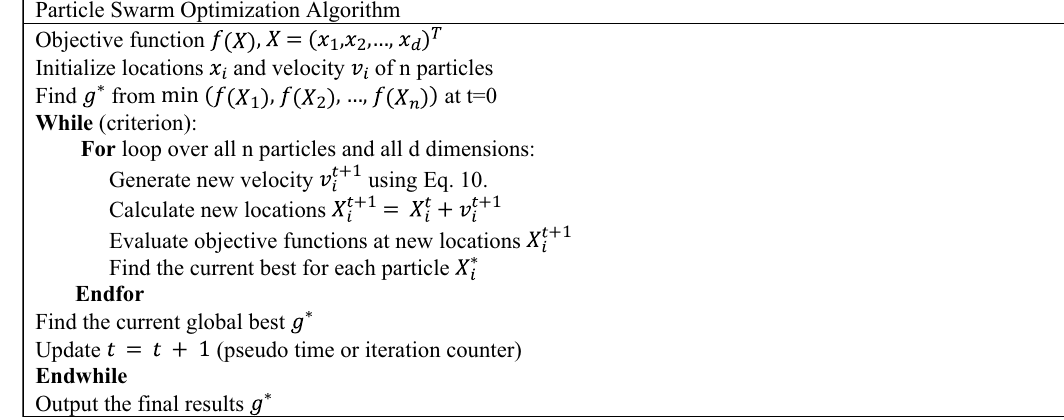
Particle Swarm Optimization